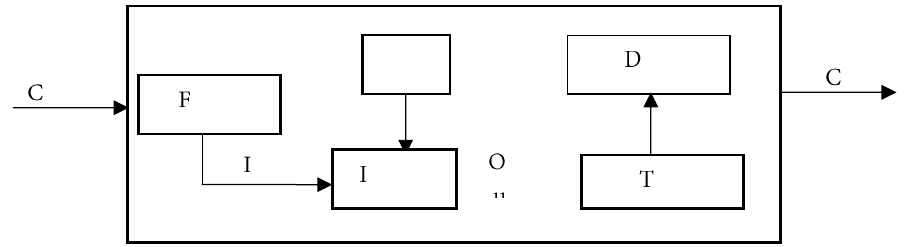
Fig. 1. Typical structure of interval type-2 fuzzy logic system